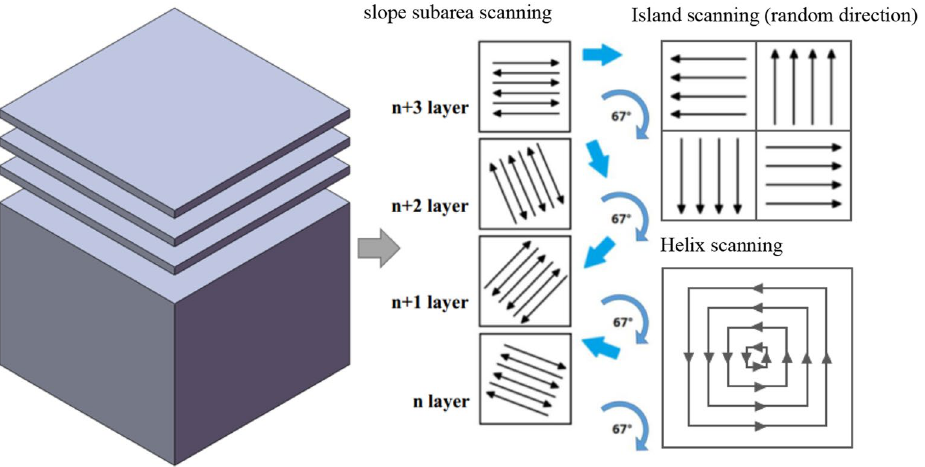
Figure 4. Schematic diagram of different scanning strategies.